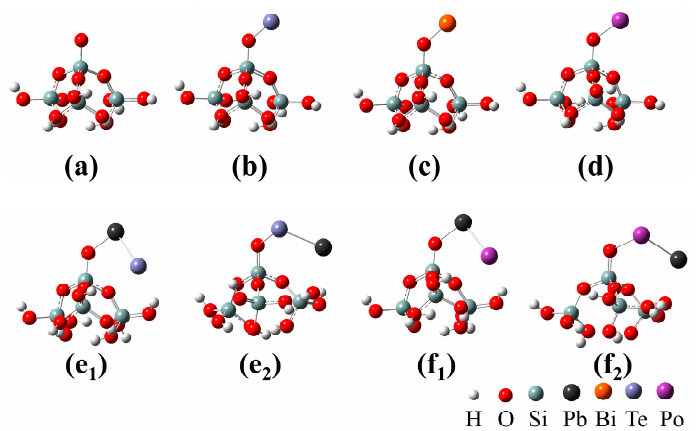
Figure 9. Adsorption configurations of monoatomic molecules (Po, Te, and Bi) and diatomic molecules (PbTe and PbPo) on the ≡ Si-O adsorption site used for density functional theory (DFT) calculations: ( a ) SiO 2 , ( b ) Te/ SiO 2 , ( c ) Bi/ SiO 2 , ( d ) Po/ SiO 2 , ( e 1 , e 2 ) PbTe/ SiO 2 , and ( f 1 , f 2 ) PbPo/ SiO 2 . Table 2. Calculated adhesion energies of monoatomic molecules and diatomic molecules on the ≡ Si- O· adsorption sites.